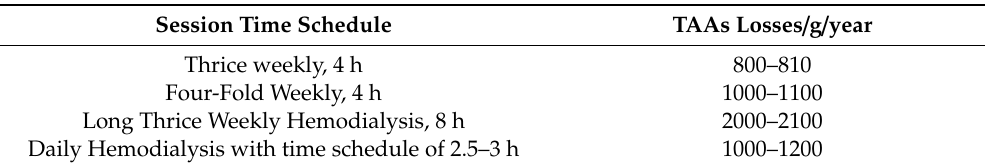
Table 2. Forecast Losses of Total Amino Acids (TAAs) through hemodialysis according to di ff erent timings and